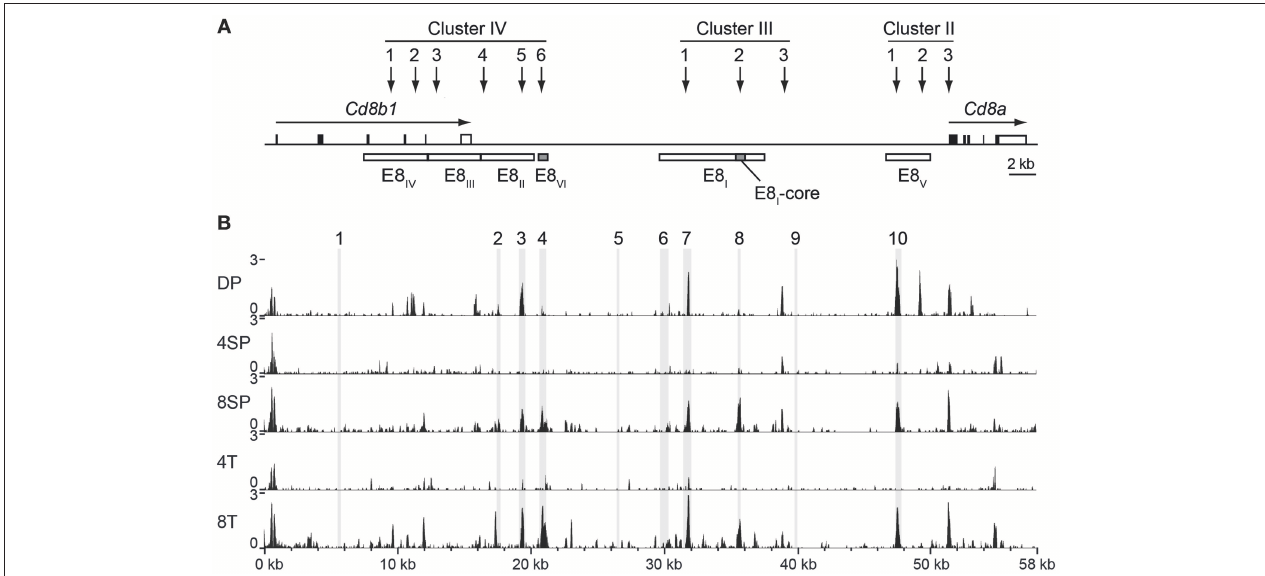
FIGURE 1 | Chromatin accessibility at the Cd8ab1 gene complex in the T cell lineage. (A) Schematic map of the Cd8a and Cd8b1 gene loci [after Gorman et al. (38)]. Horizontal arrows indicate the transcriptional orientation of the Cd8a and Cd8b1 genes. Vertical arrows indicate the localization of DNase I hypersensitivity sites that constitute clusters II, III, and IV (11, 36). The boxes below the Cd8ab1 gene complex indicate the location of Cd8 enhancers E8 I to E8 VI . The E8-core and E8 VI regions are indicated as shaded boxes. (B) UCSC genome browser snapshots showing the ATAC-seq signals at the Cd8ab1 gene complex (GRCm38/mm10, chr6: 71322001-71380000) in double-positive (DP), CD4 single-positive (4SP), CD8 single-positive (8SP) thymocytes, CD4 + T (4T) and CD8 + T (8T) cells. The ATAC-seq data were obtained from the Immunological Genome Project (ImmGen) (22). Shaded bars indicate the location of ECR1 to ECR10 as previously described